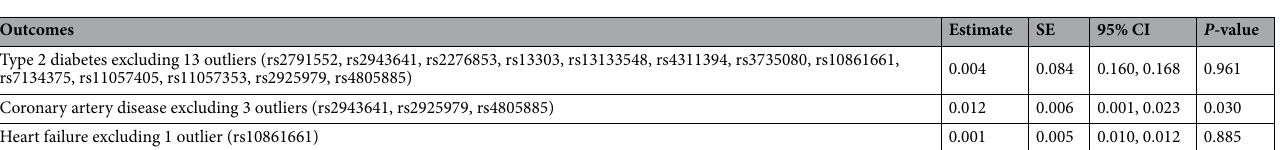
Table 3. Mendelian randomization estimates between adiponectin and outcomes after excluding outliers detected by MR-PRESSO.